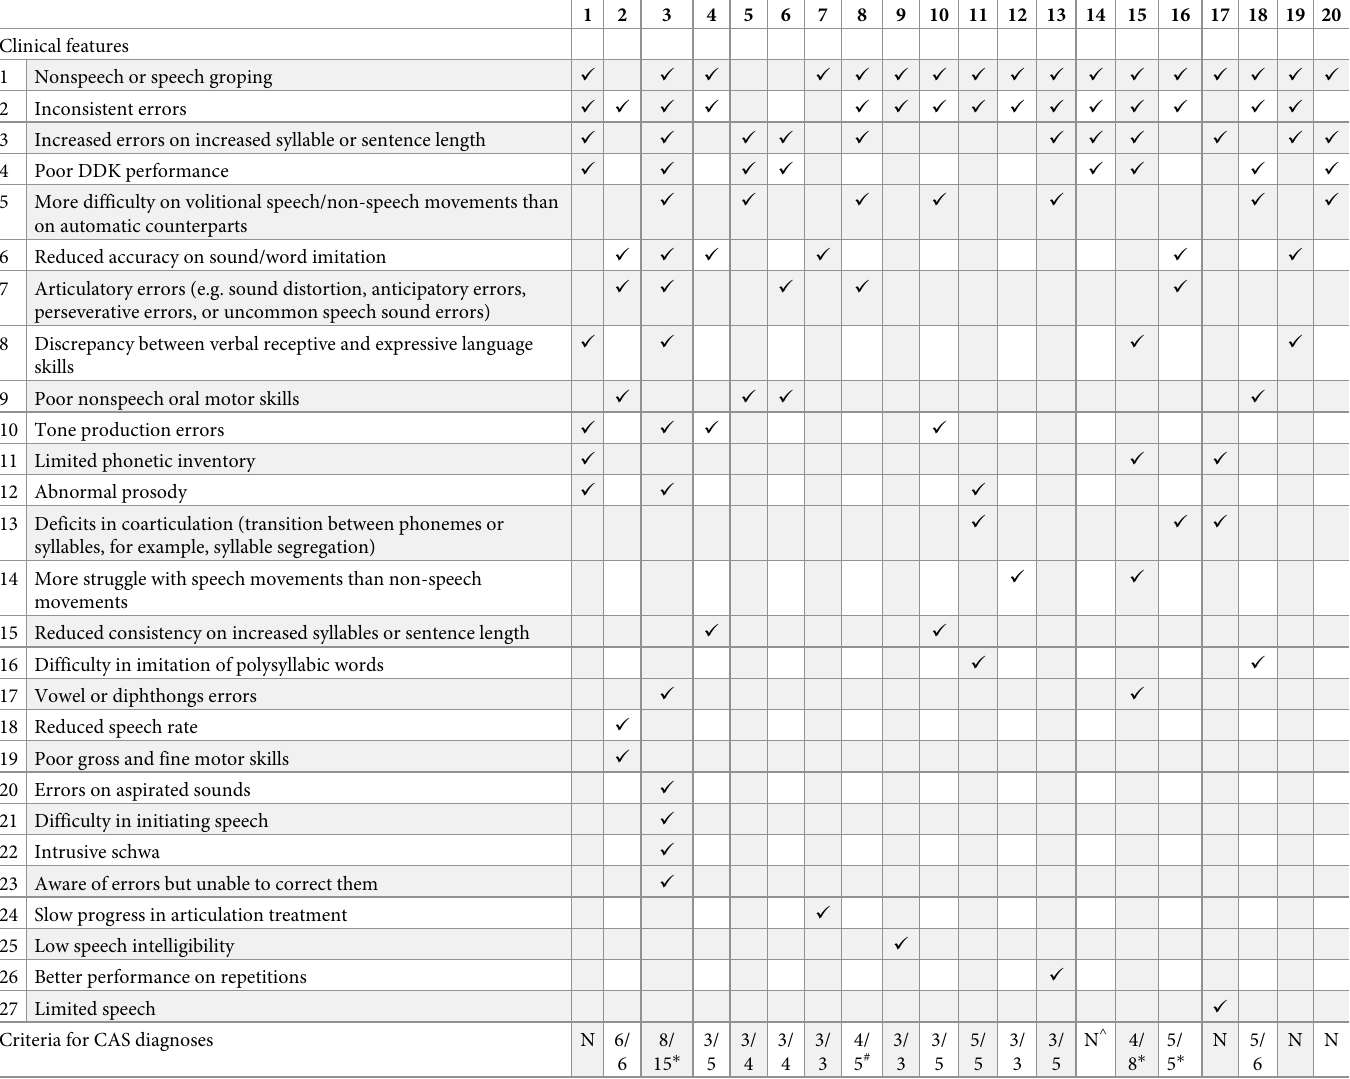
Table 2. Summary of the clinical features used by 20 speech-language therapists in Hong Kong for childhood apraxia of speech diagnoses in Cantonese speakers.